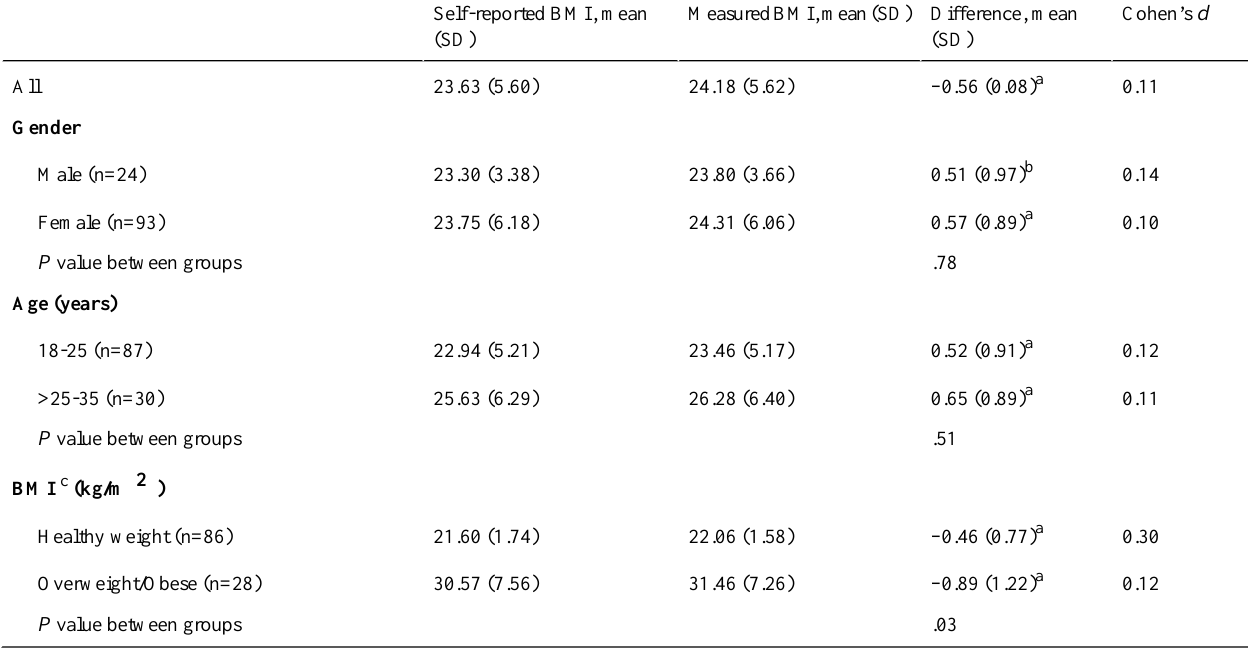
Table 3. Differences between Web-based self-reported and measured BMI (kg/m 2 ) in adults (n=117) grouped by BMI, age, and